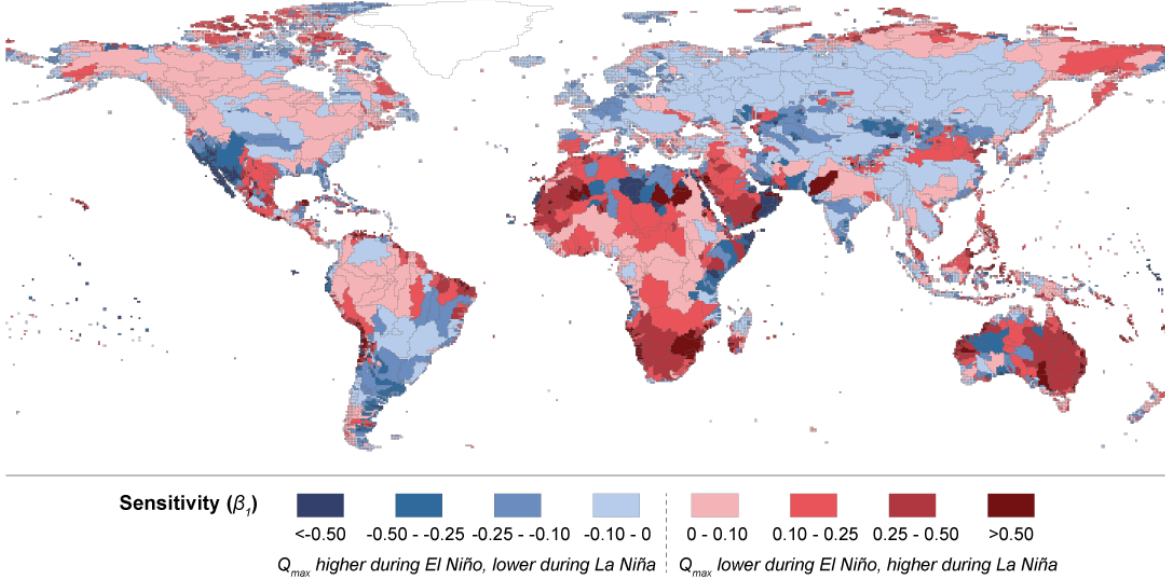
Fig. A4. Sensitivity ( β 1 ) of ln Q max to variations in SOI. Negative correlation generally represents higher annual floods in El Niño years/lower annual floods in La Niña years, while positive correlation generally represents the opposite. For these results, no significance testing has been carried